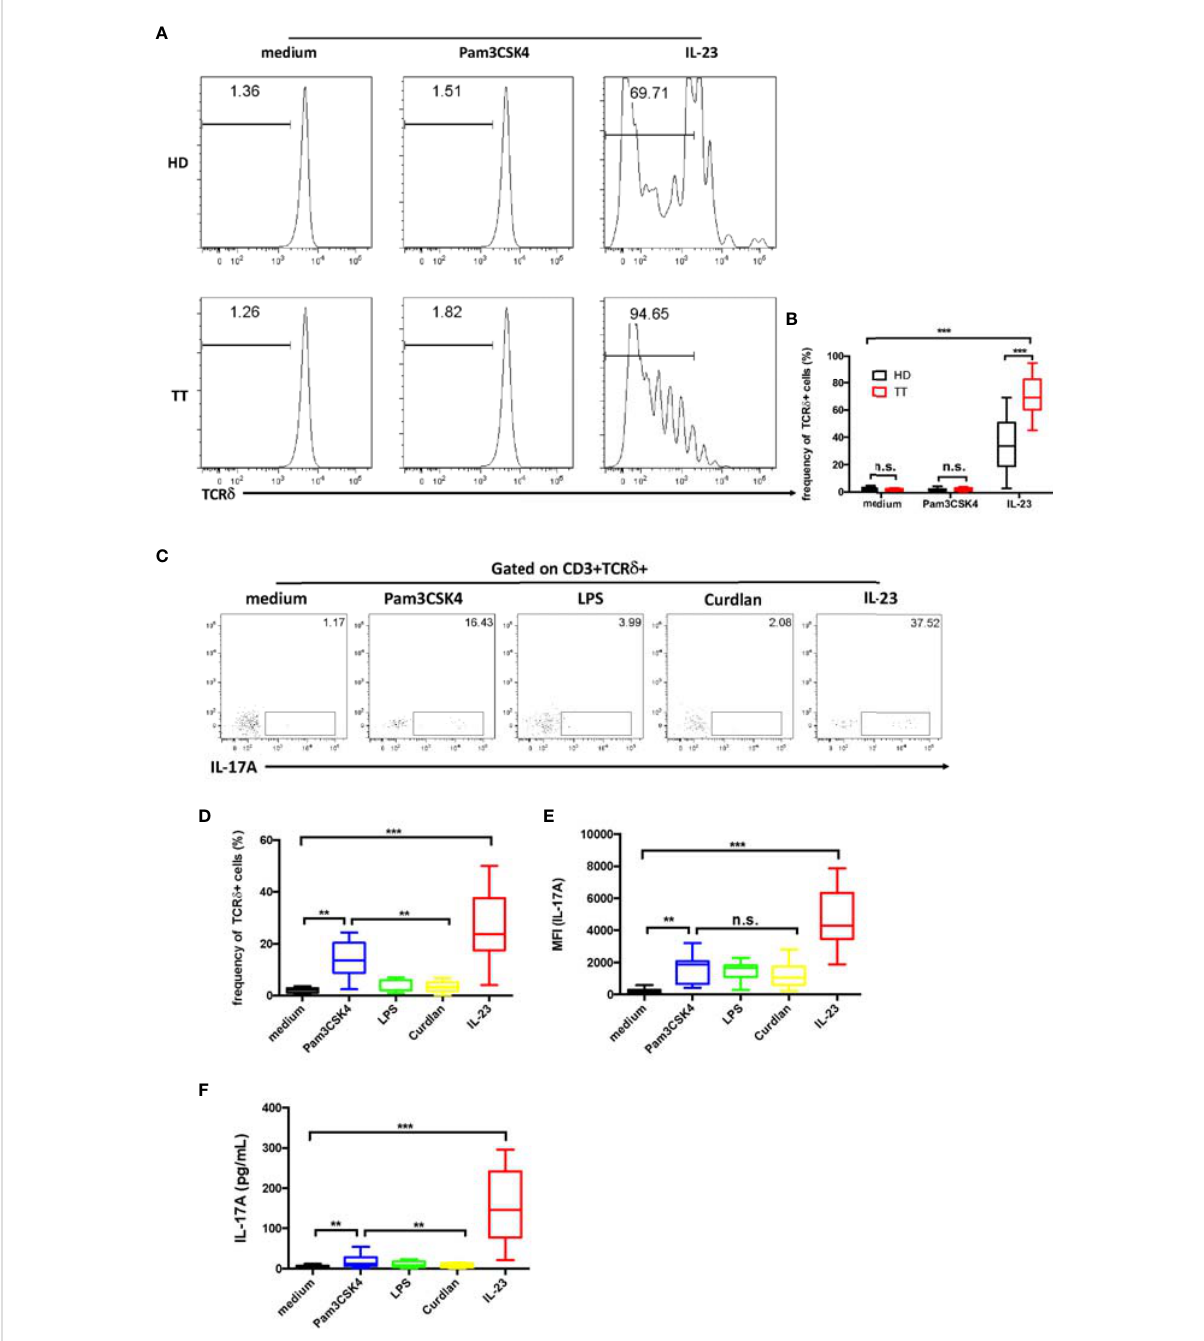
FIGURE 6 Dermal gd T cells ex vivo expansion and IL-17A production upon IL-23 stimulation. (A) Dermal cells were labeled with Carboxy fl uorescein succinimidyl ester (CFSE) and then stimulated with Pam3CSK4 or IL-23 for 4 days. Cells were analyzed by fl ow cytometry with CD3 and TCR d staining. (B) Statistical results in (A) . (C) Dermal cell suspensions were stimulated with Pam3CSK4, LPS, Curdlan, or IL-23 for 48h. IL-17A production was determined by fl ow cytometry. (D, E) Statistical results in (C) . (F) Supernatants harvested from (B) were examined for IL-17A secretion by ELISA. Statistical analysis was performed by two-way ANOVA or one-way ANOVA. n.s.: no signi fi cance; ** p < 0.01; *** p <